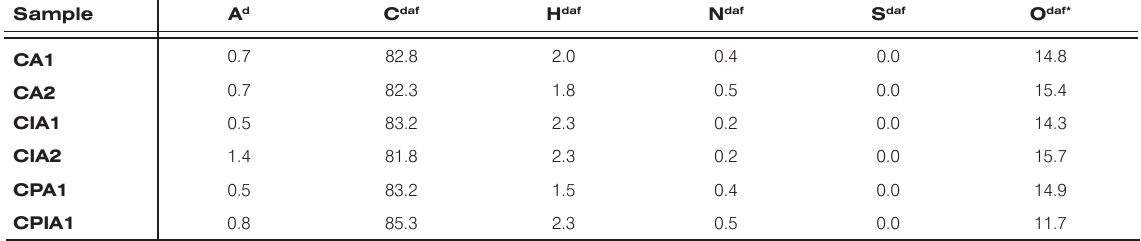
Table 2. Elemental analysis of activated carbons obtained [wt.%].